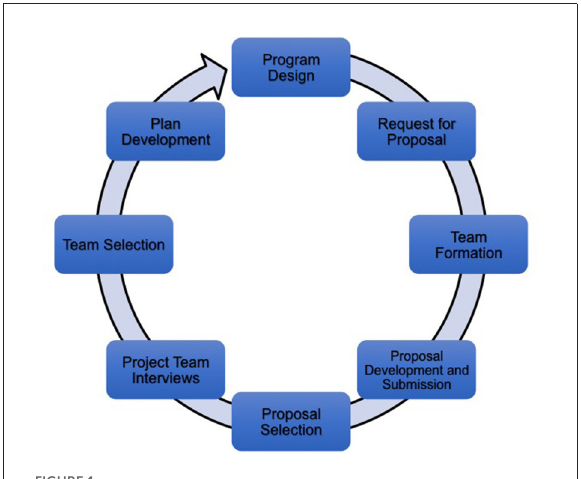
FIGURE1 Common stages of a just climate adaptation policy implementation